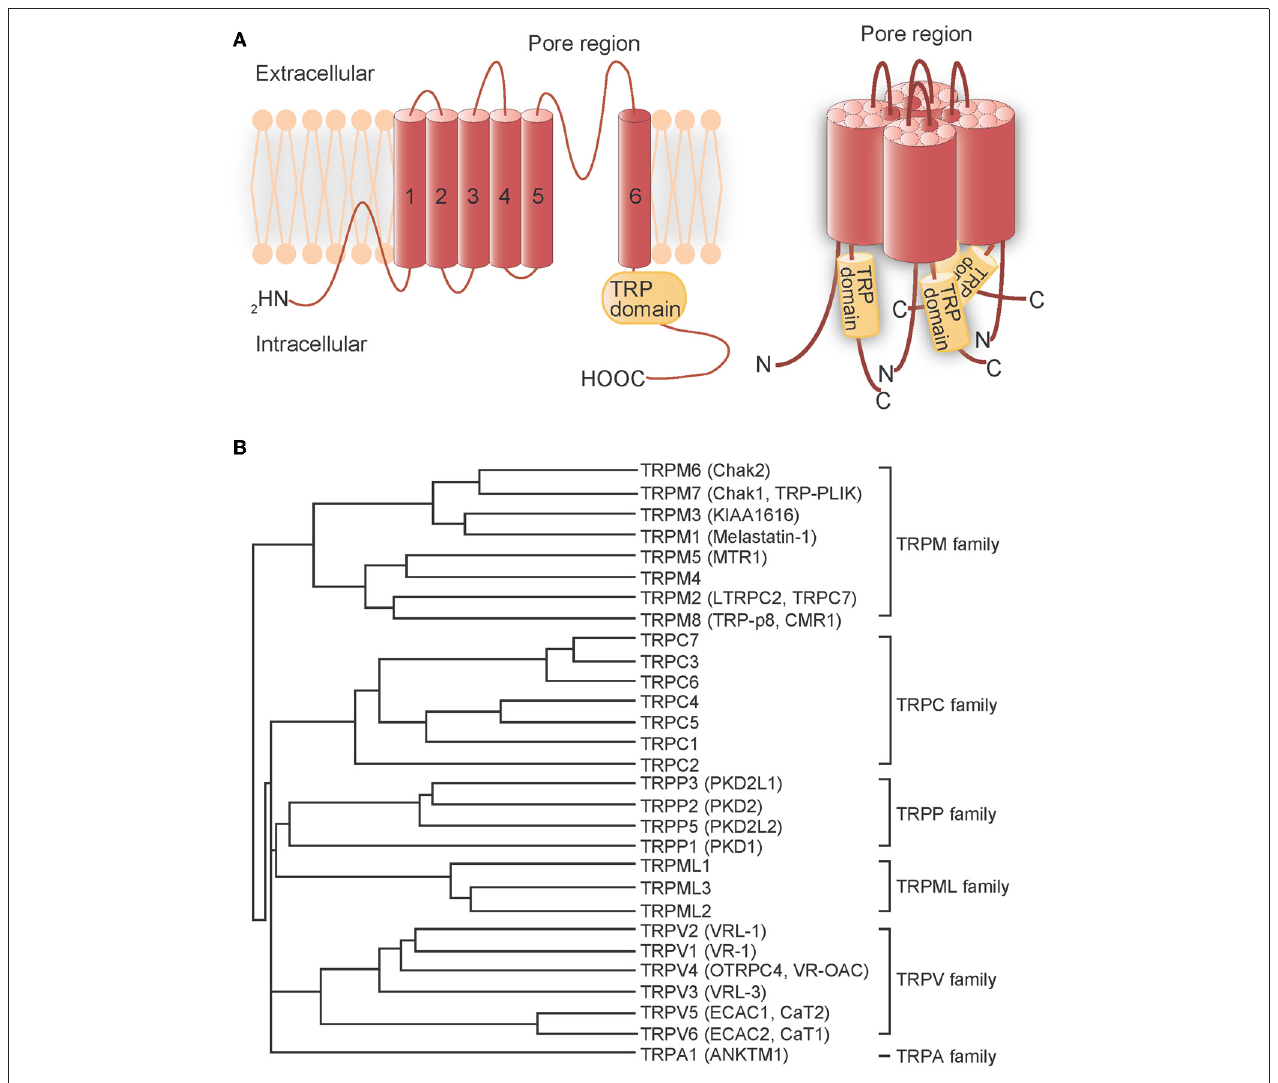
FIGURE 1 | Transmembrane topology and phylogenetic tree of mammalian TRP channels. (A) Transmembrane topology (left) and the quartenary structure of TRP channels (right). The TRP protein has six putative transmembrane domains, a pore region between the fifth and sixth